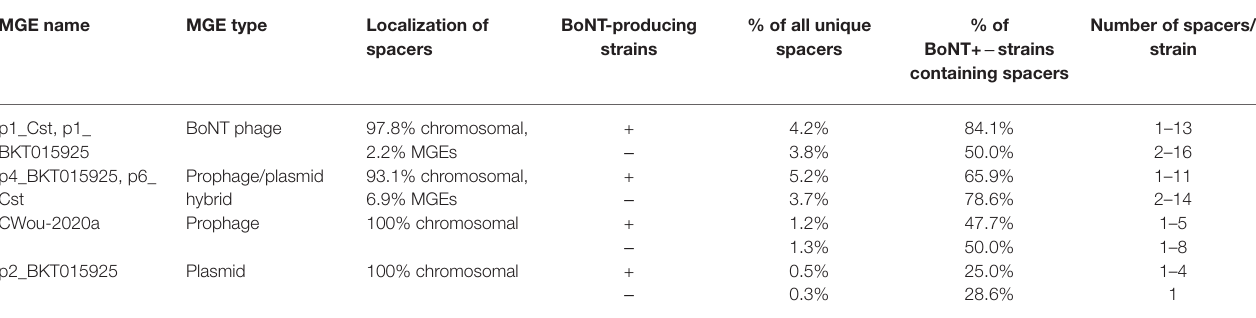
TABLE 3 | Spacers targeting the restricted mobilome.